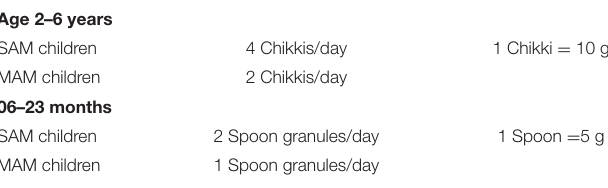
TABLE 1 | Quantity of chikki bars/granules distributed to beneficiaries during intervention. Age 2–6